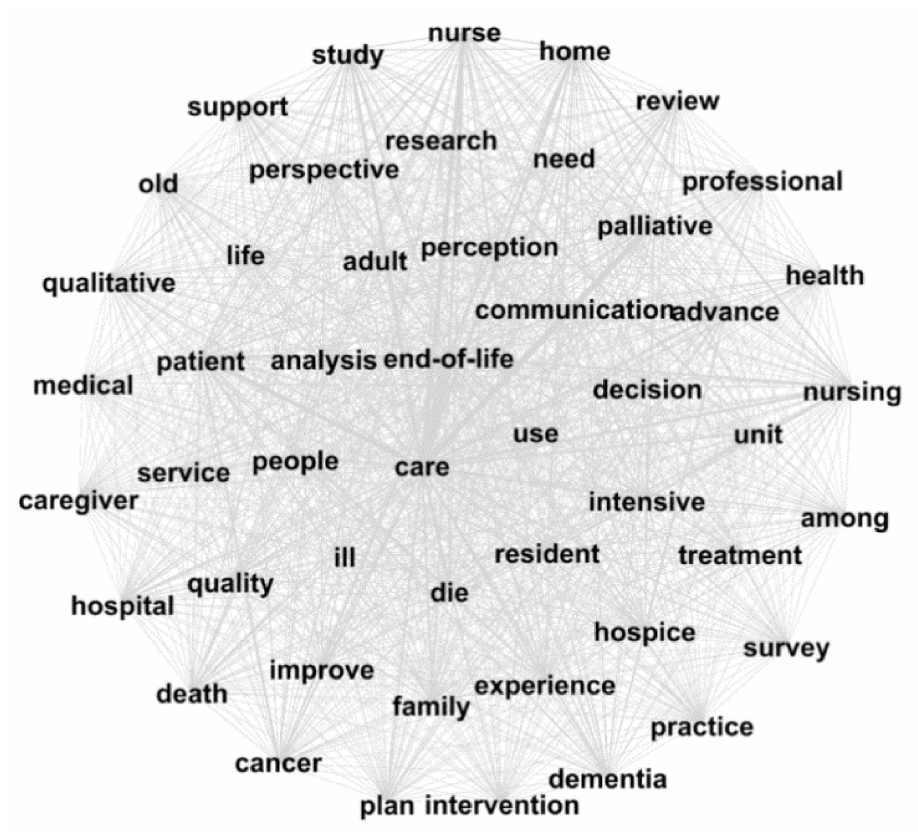
Figure 2. Semantic network analysis of